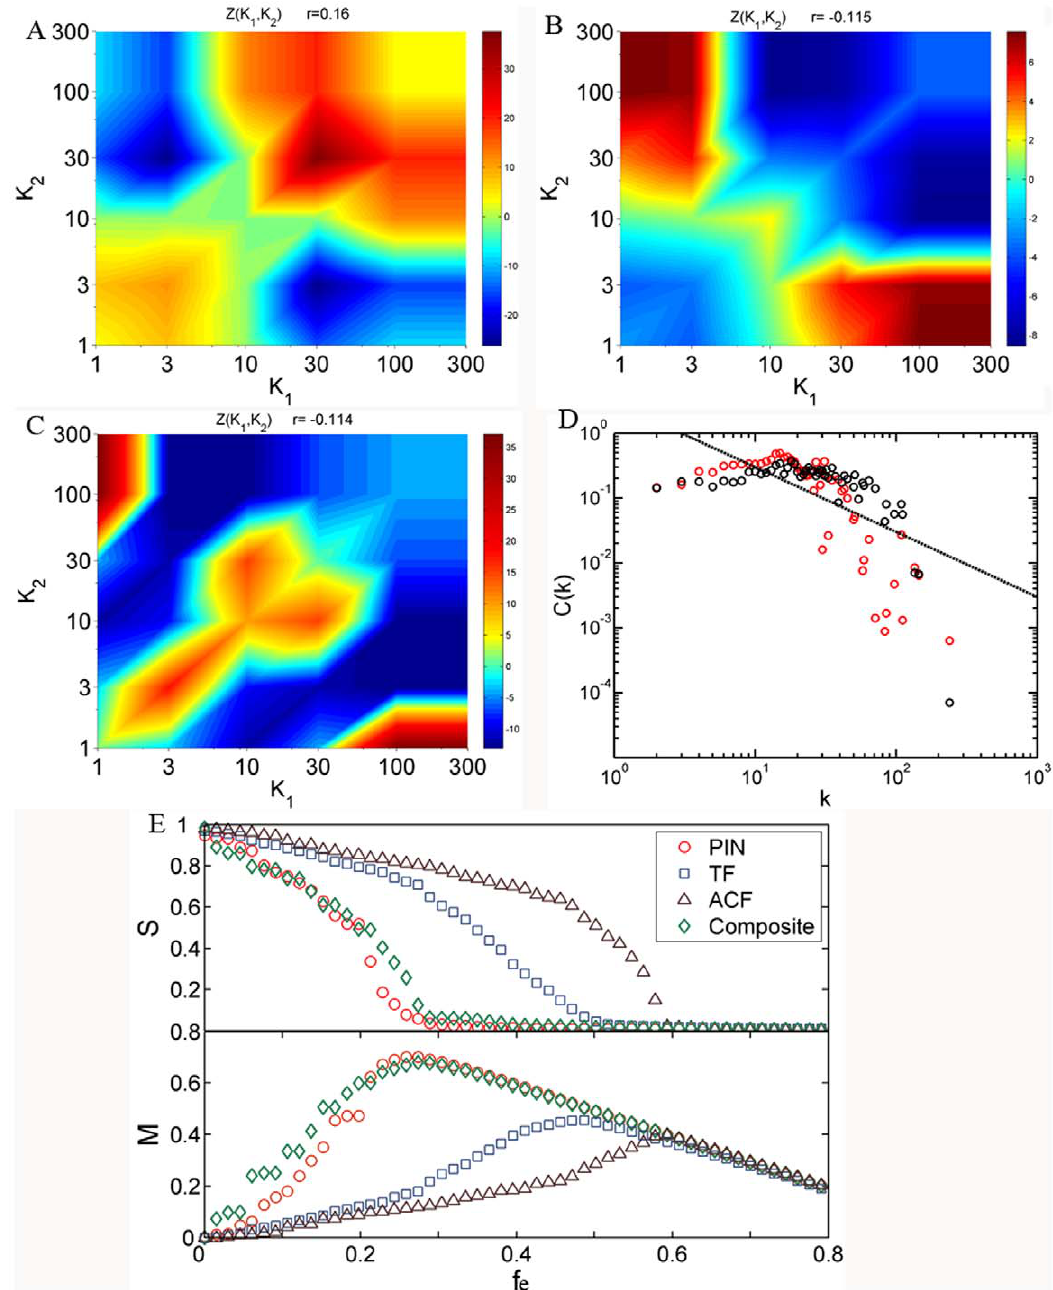
Figure 5. Degree correlation and modularity. A . The correlation profile of the triangle-favoring network. Note that the network is assortative. B . The correlation profile of the anti-correlation favoring network. Note that the network is disassortative. C . The correlation profile of the composite network, which presents a dichotomy in degree correlation. D . The two C(k) curves of the composite network ( T =1, black circles) and PIN of HC dataset (red circles) overlaps in a great extent. E . The strength of modularity, M and the relative size of largest component, S during the removal of a fraction f e of intermodular edges for the triangle-favoring (TF) network, the anti-correlation favoring (ACF) network, the composite network and PIN of HC dataset.